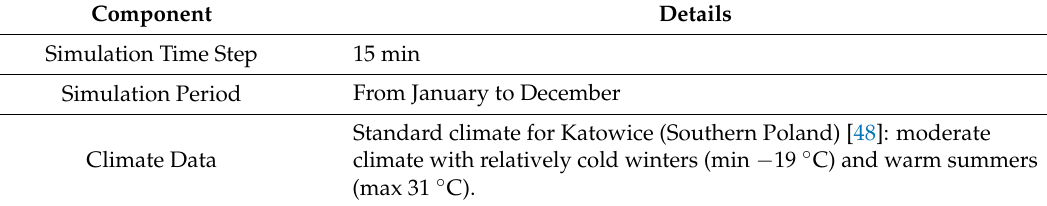
Table 3. Input data to case study simulations.